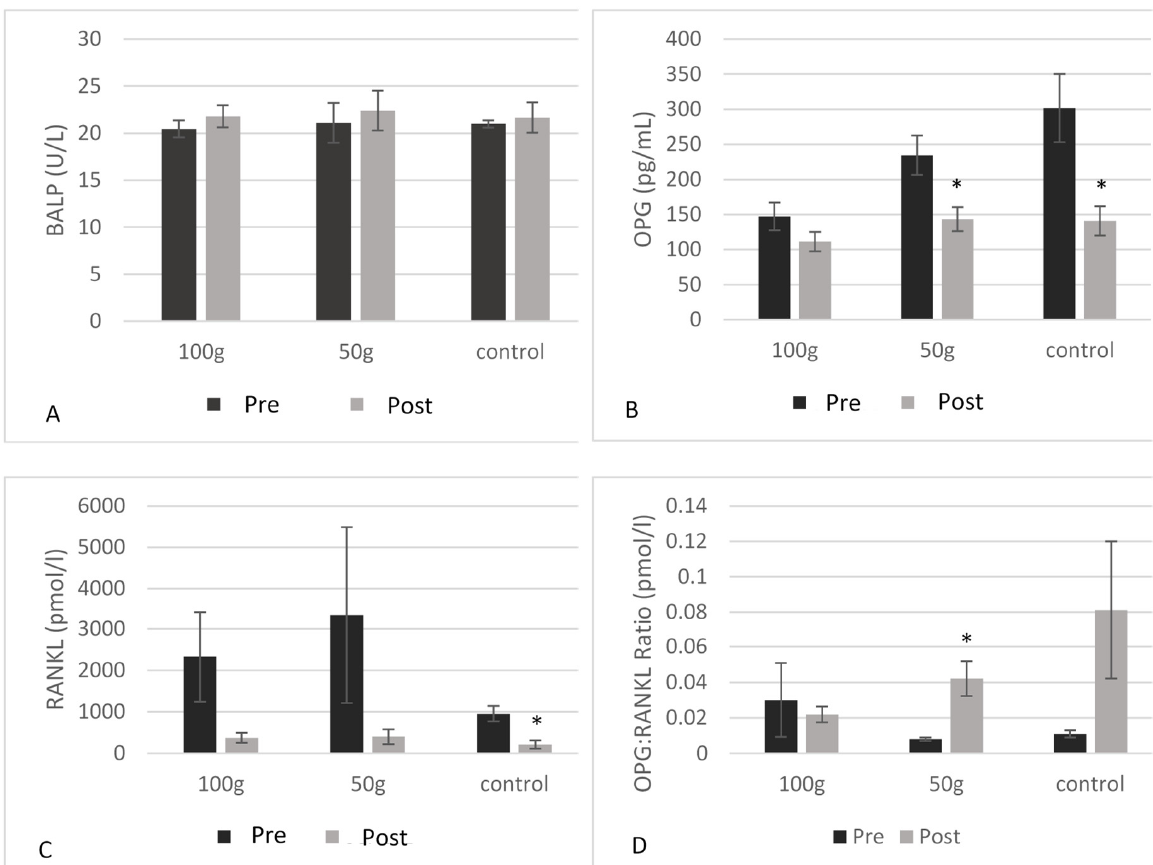
Figure 4. Blood BALP ( A ), blood OPG ( B ), blood RANKL ( C ), and the OPG:RANKL ratio ( D ) in men